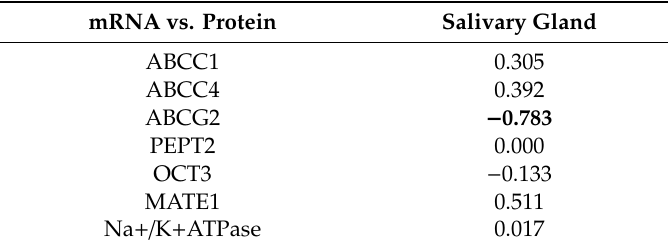
Table 1. Correlation between mRNA and protein level of ABC and SLC transporters in the human parotid salivary gland. Correlation coefficients were assessed using the Spearman’s rank test. Bold font indicates p value < 0.05.